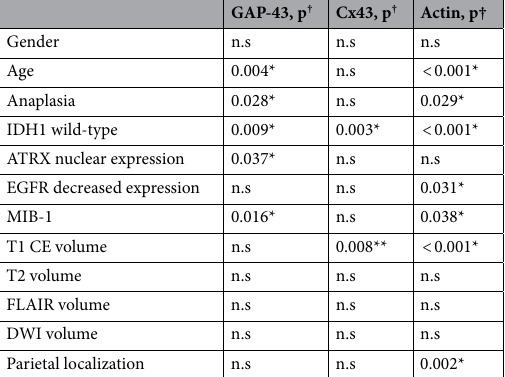
Table 3. The association of GAP-43, Cx43 and actin expression with epidemiologic, neuropathological and radiological variables. *Direct association, **Opposite association. † p < 0.05 is considered as significant, otherwise “n.s.” is